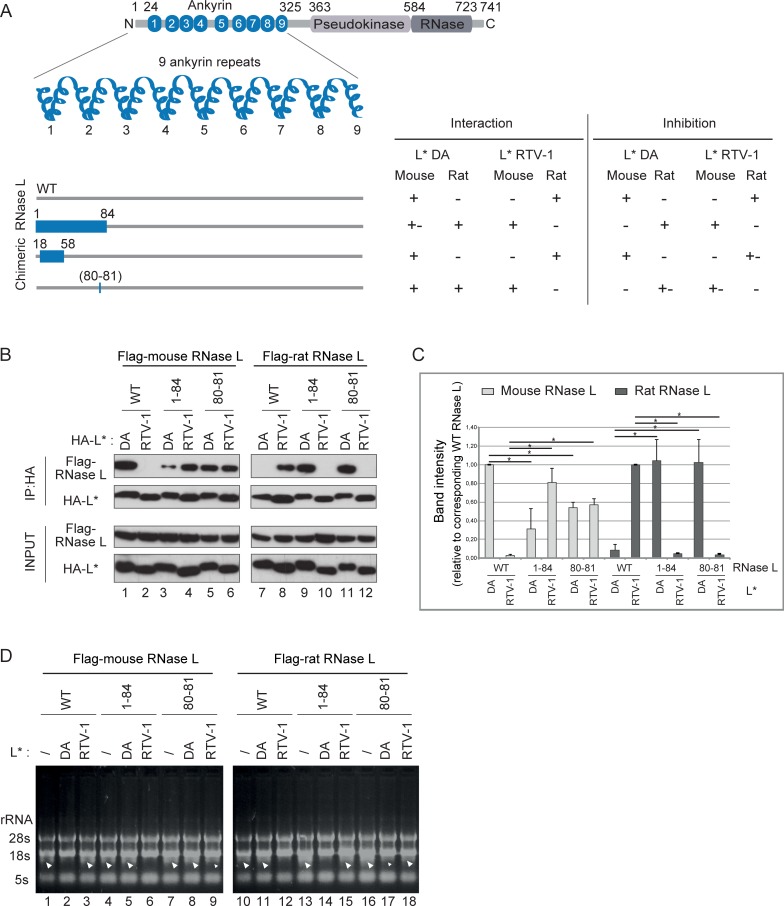
Amino acids 81 and 82 of the mouse RNase L are also necessary for interaction with and inhibition by L*.A. Segments of decreasing size were swapped between rat and mouse RNase L and the resulting chimeric RNase L were tested for inhibition by and interaction with L*DA (mouse virus) and L*RTV-1 (rat virus). Schematic rat/mouse chimeric RNase L are represented as in Fig 2. The right columns indicate whether L*DA and L*RTV-1 interact with and inhibit the chimeric enzymes. B-C. Immunoblots (B) show Flag and HA detection after immunoprecipitation of HA-L* (IP:HA) and in cell lysates (Input). Graphs (C) show the mean and SD of the amount of co-immunoprecipitated RNase L chimera relative to that of WT RNase L of the corresponding species (n = 3). *: p<0.05 in a two-way ANOVA followed by Dunnett’s test for multiple comparison. D. Analysis of RNase L-mediated RNA degradation in HeLa-M cells overexpressing indicated Flag-RNase L and L*DA or L*RTV-1. RNA samples were extracted 7 hours after polyI:C transfection. Arrowheads point to rRNA cleavage products. Reproducible results were obtained in 2 independent experiments.